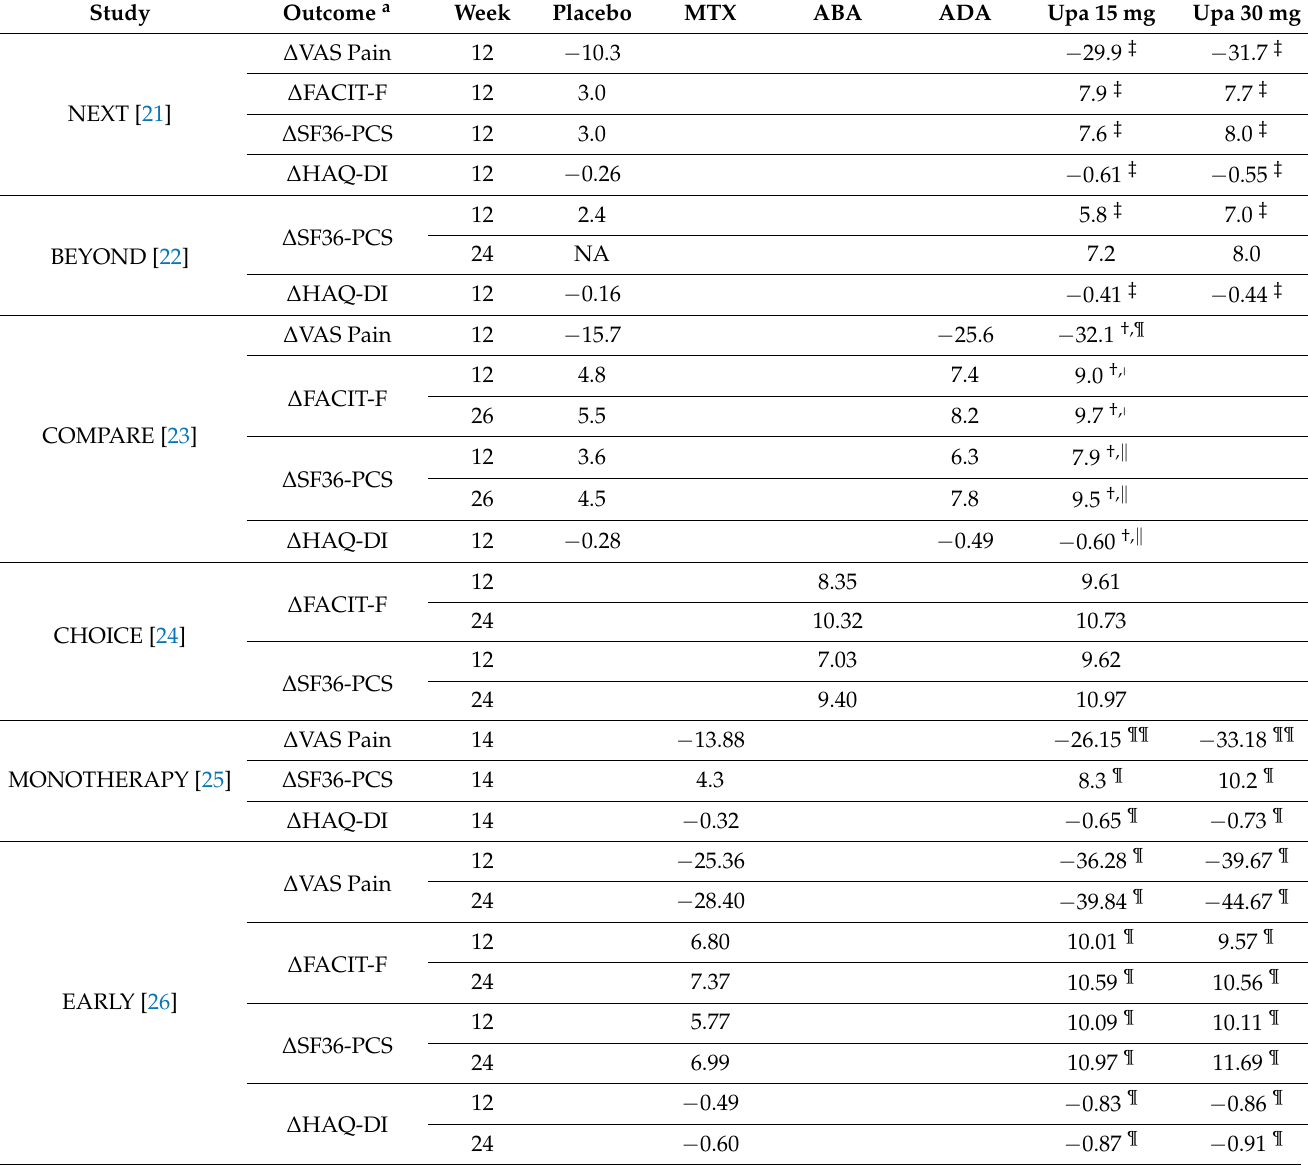
Table 4. Results of upadacitinib on key patient-reported outcomes in the SELECT trial